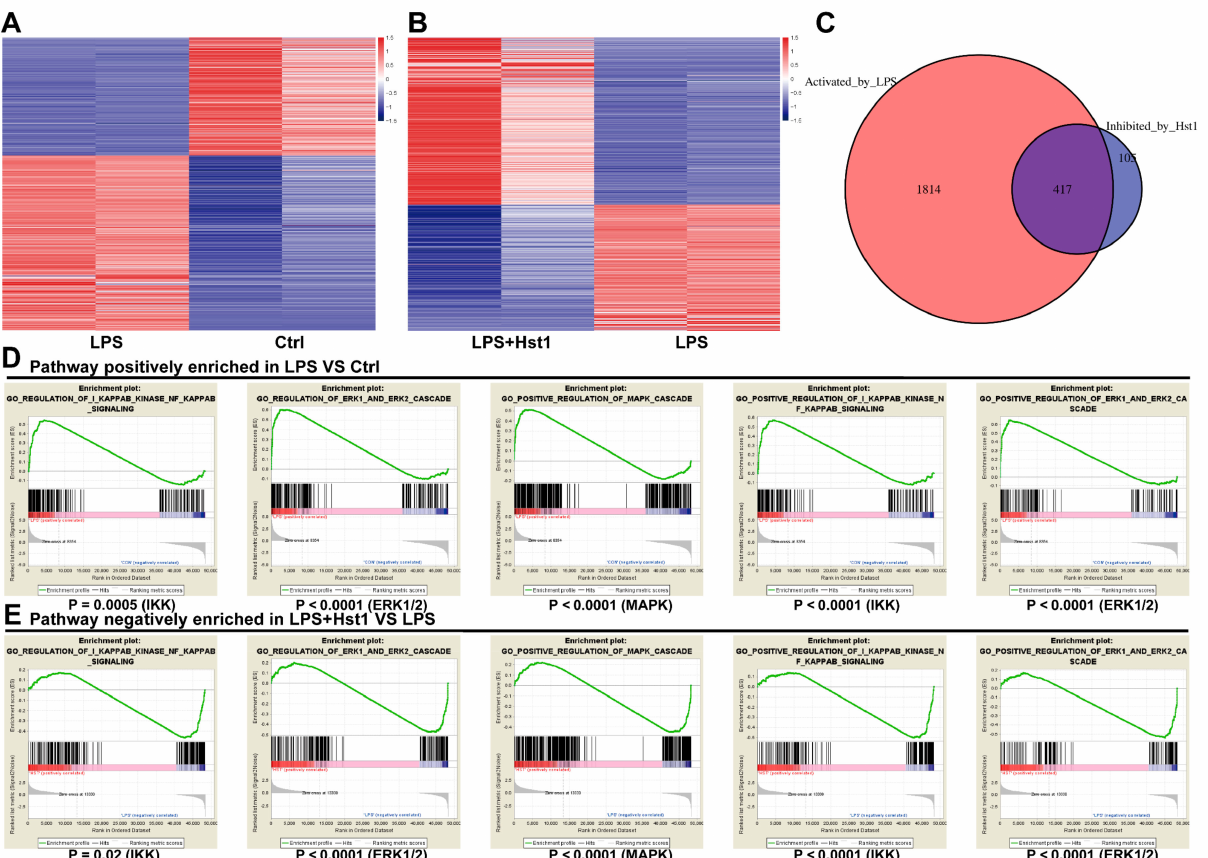
Figure 6. High-throughput gene sequencing of macrophages. ( A , B ) Differential mRNA expression of RAW264.7 macrophages in each group. ( C ) mRNA intersections of LPS vs. control upregulated genes and LPS+Hst1 vs. LPS downregulated genes. Gene set enrichment analysis (GSEA) shows enrichment of the NF- κ B and MAPK pathways. ( D ) Pathways positively enriched in LPS group vs. control group and ( E ) pathways negatively enriched in LPS+Hst1 group vs. LPS